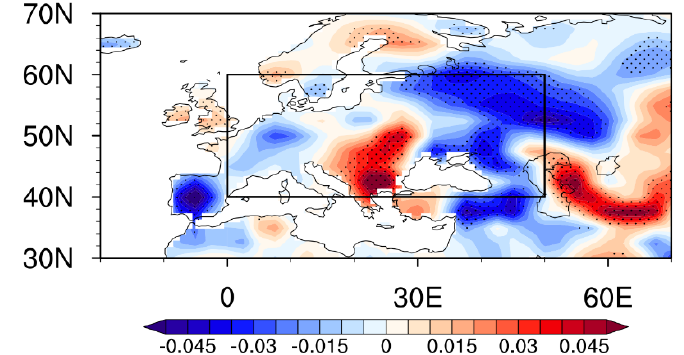
Figure 4. Anomalies of volumetric soil moisture between 0 and 10 cm (unit: fraction) in June of 2019 relative to 1948–2019. Stippling regions represent soil moisture anomalies exceeding one standard deviation from 1948 to 2019.